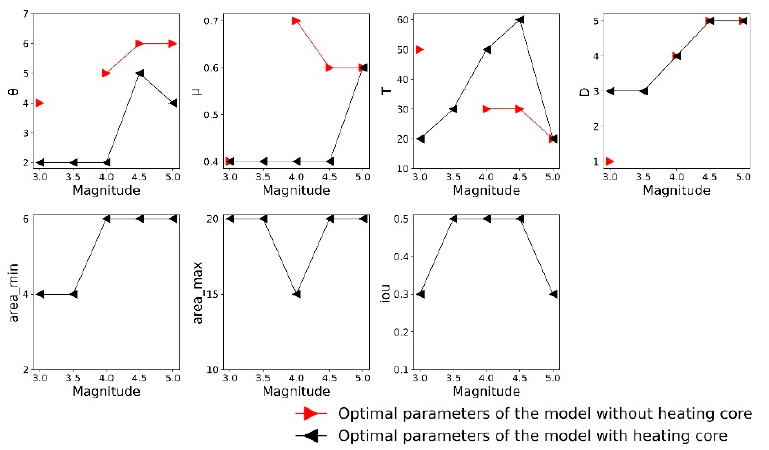
Figure 11. The optimal parameters of the models with/without a “heating core” when the moving window scale is 100 under different magnitude parameters.